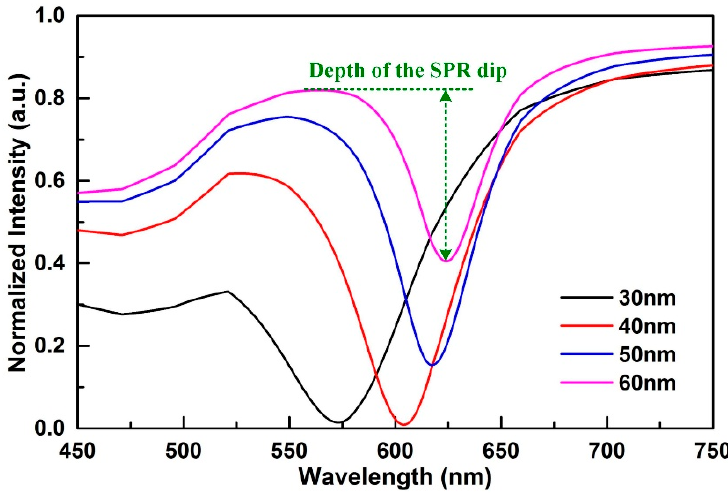
Figure 2. The transmitted spectrum under different gold film thicknesses.